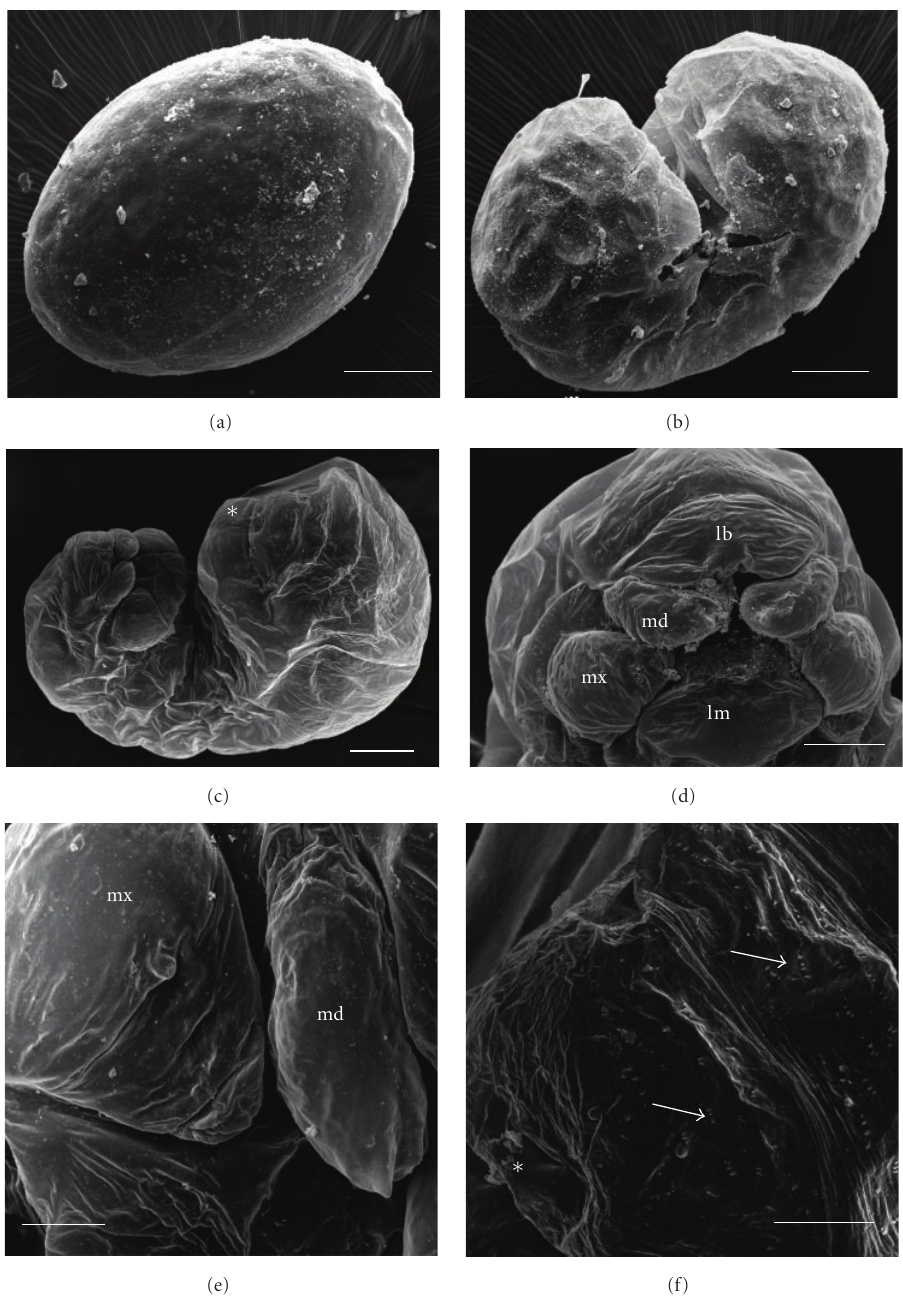
Figure 1: Egg and first instar larva of Solenopsis saevissima . (a) Egg. (b) Hatching larva. (c) Oblique view of first instar larva; inset: thoracic spiracle. (d) Head capsule and mouthparts; lb: labrum; md: mandible; mx: maxilla; lm: labium. (e) Detail of mouthparts, showing right maxilla and mandible. (f) Terminal region of body, showing anus (asterisk) and rows of spinules (setae). Respective sizes of scale bars ( µ m): 50, 25, 50, 20, 10, and